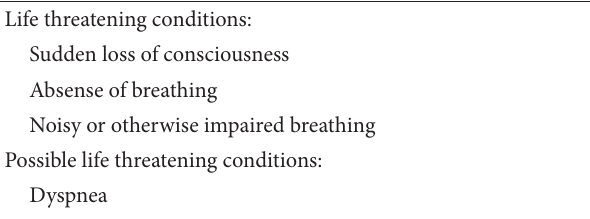
Table 1: MECU Dispatch criteria in the observation